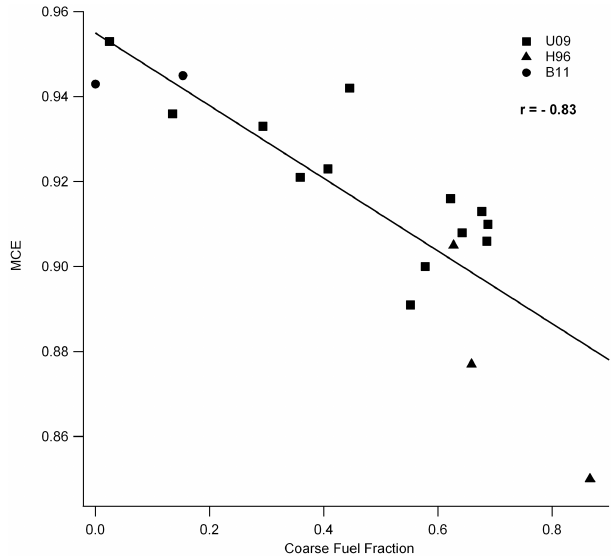
Fig. 5. Plot of MCE vs. coarse fuel fraction (the ratio of coarse fuel consumption to total fuel consumption) for 18 prescribed fires from previous studies (B11; U09; H96; Ottmar and Ward, 1996; Ottmar and Vihnanek, 1995; Reardon, 2012; Harrington, 2012). Coarse fuel is CWD and duff. See Sect. 3.4 and Appendix A for